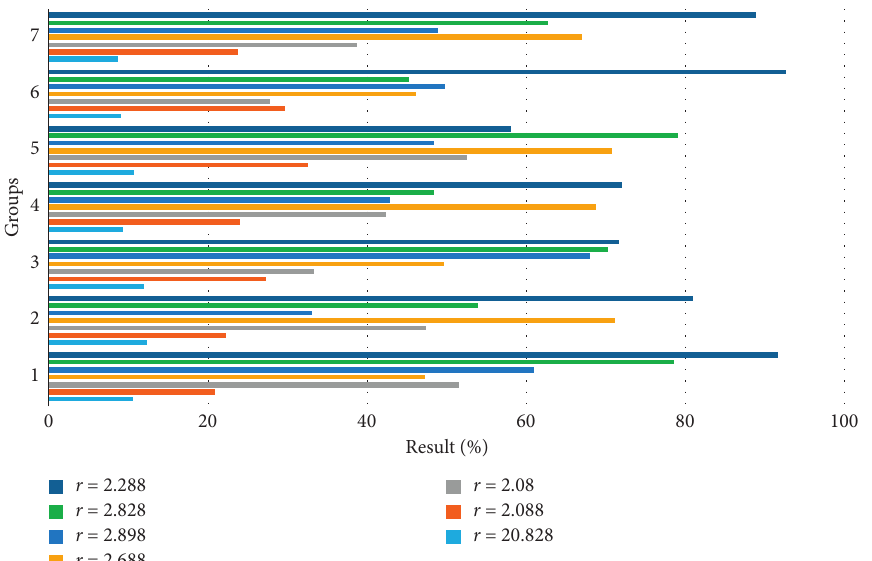
Figure 3: The revised results of the index system.